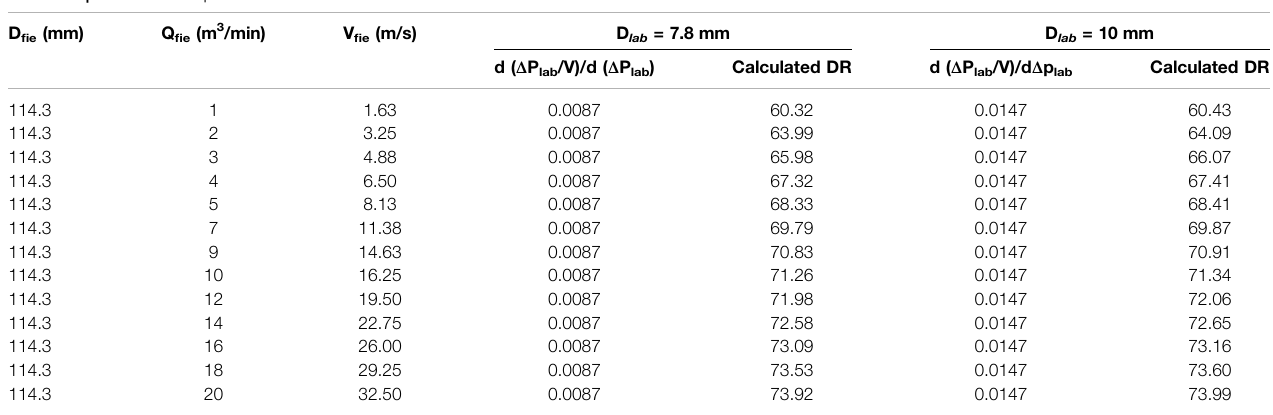
TABLE 2 | Data used for parameter